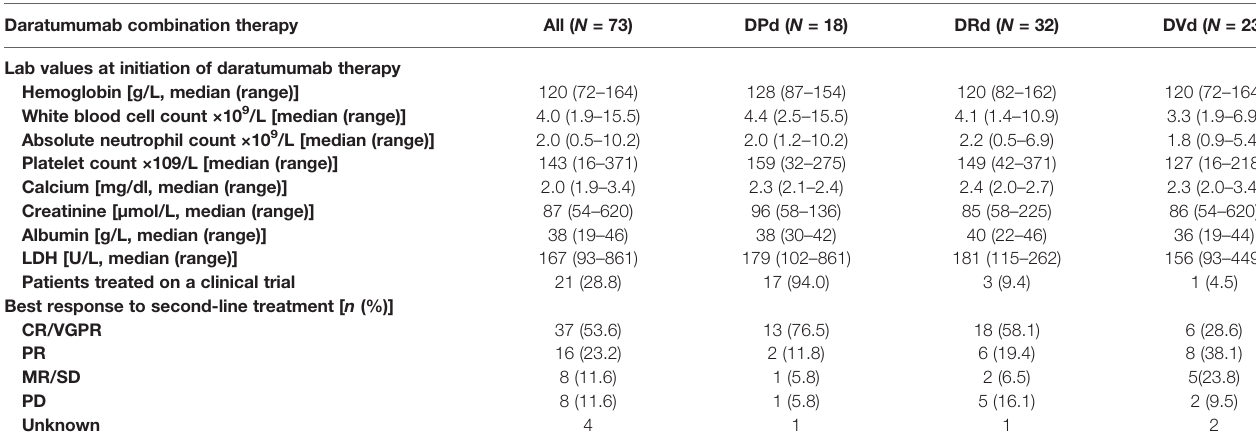
TABLE 3 | Baseline lab values at initiation and responses on daratumumab based therapy. Daratumumab combination